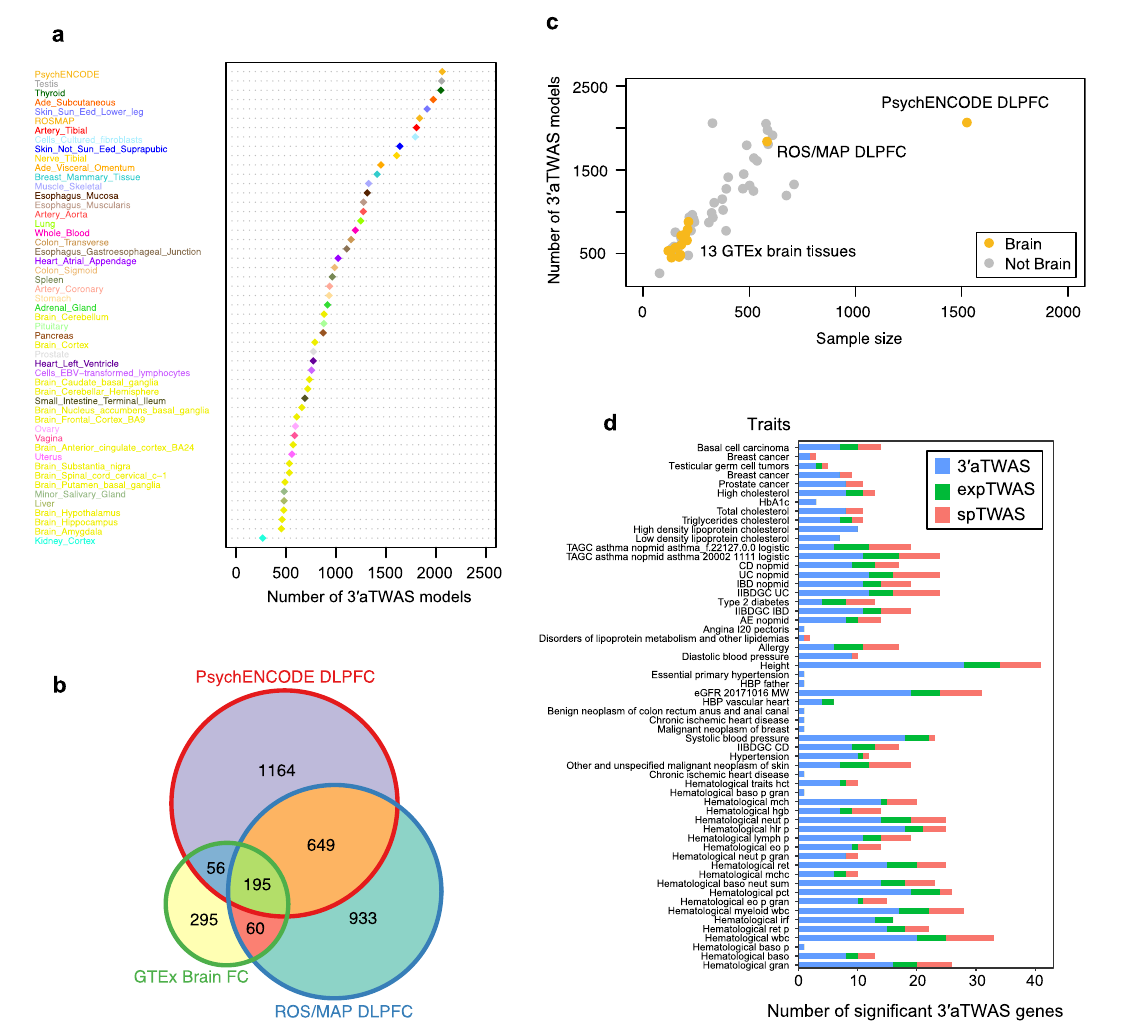
Fig.3|3 ′ aTWAShubacross13braintissuesand36non-braintissuesfromROS/ MAP, PsychENCODE, and GTEx cohorts. a Number of 3 ′ aTWAS models across each tissue from ROS/MAP, PsychENCODE, and GTEx cohorts. DLPFC, dorsolateral prefrontal cortex. b Venn diagram showing the overlap between the number of 3 ′ aTWAS models in ROS/MAP DLPFC, PsychENCODE DLPFC, and GTEx Brain frontal cortex (FC) tissues. c The number of 3 ′ aTWASmodelsishighly correlated with the